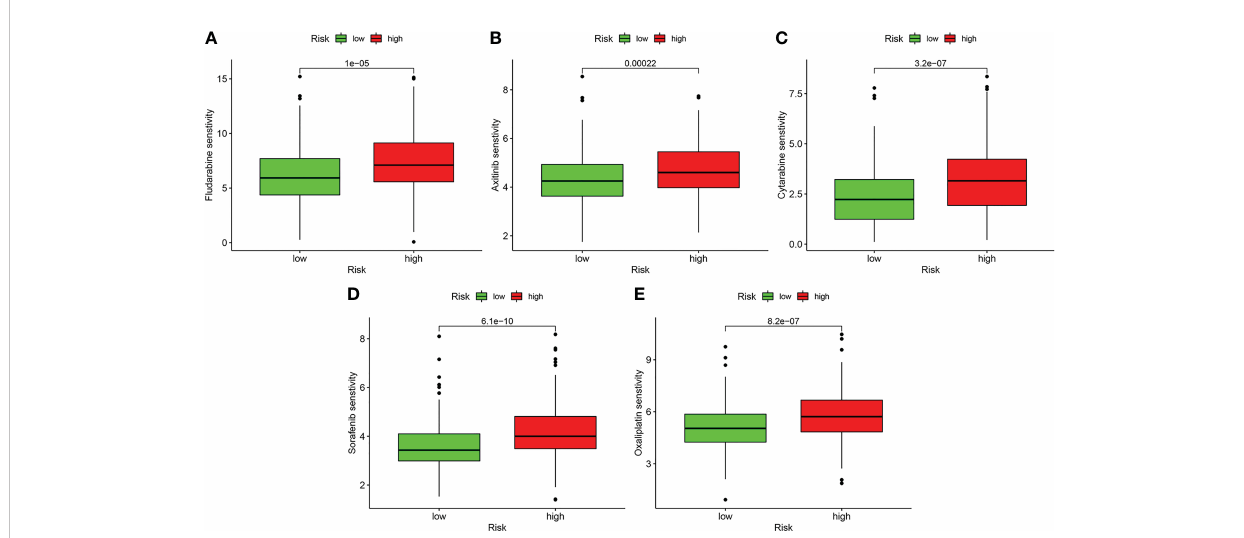
FIGURE 12 Drug sensitivity analysis. (A) Fludarabine. (B) Axitinib. (C) Cytarabine. (D) Sorafenib. (E) Oxaliplatin.